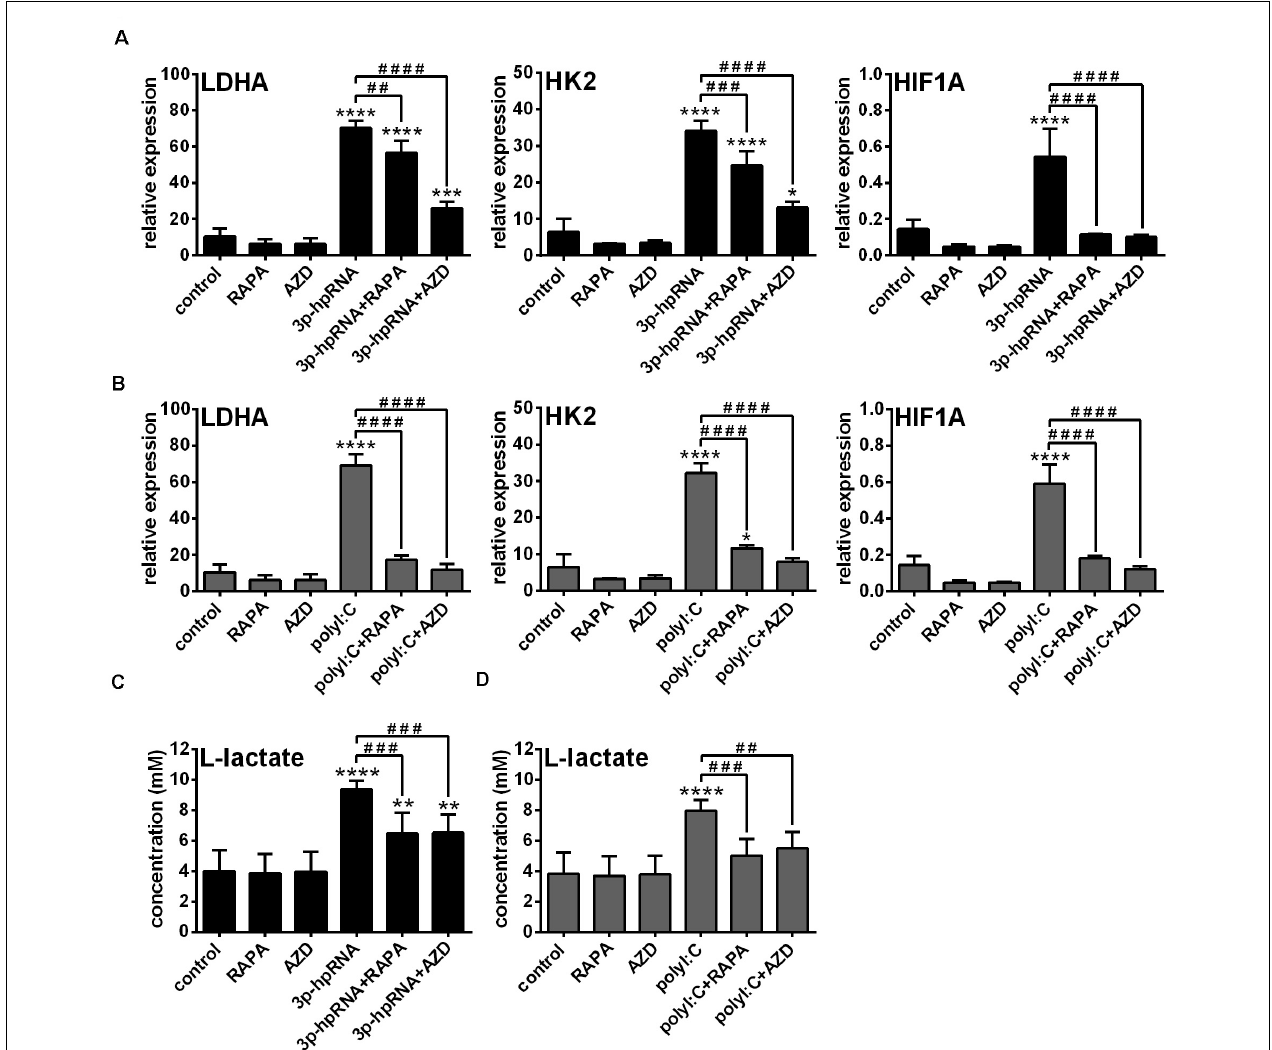
FIGURE 2 | The RLR-mediated shift to glycolysis is impaired upon mTOR inhibition in moDCs. Immature moDCs were pre-treated with vehicle control, 100 nM rapamycin (RAPA) or 100 nM AZD8055 (AZD) for 2 h and then stimulated with 3p-hpRNA (0.5 µ g/ml) (A,C) or polyI:C (1 µ g/ml) (B,D) for 12 h. (A,B) The expression of LDHA , HK2 and HIF1A was assessed at the mRNA level by real-time PCR. Bar graphs represent the mean ± SD of 4 independent experiments. (C,D) Lactate concentrations were measured from cell culture supernatants. Bar graphs represent the mean ± SD of 6 independent experiments. * p < 0.05, ** p < 0.01, *** p < 0.01, **** p < 0.0001 vs. control; ## p < 0.01, ### p < 0.001, #### p <